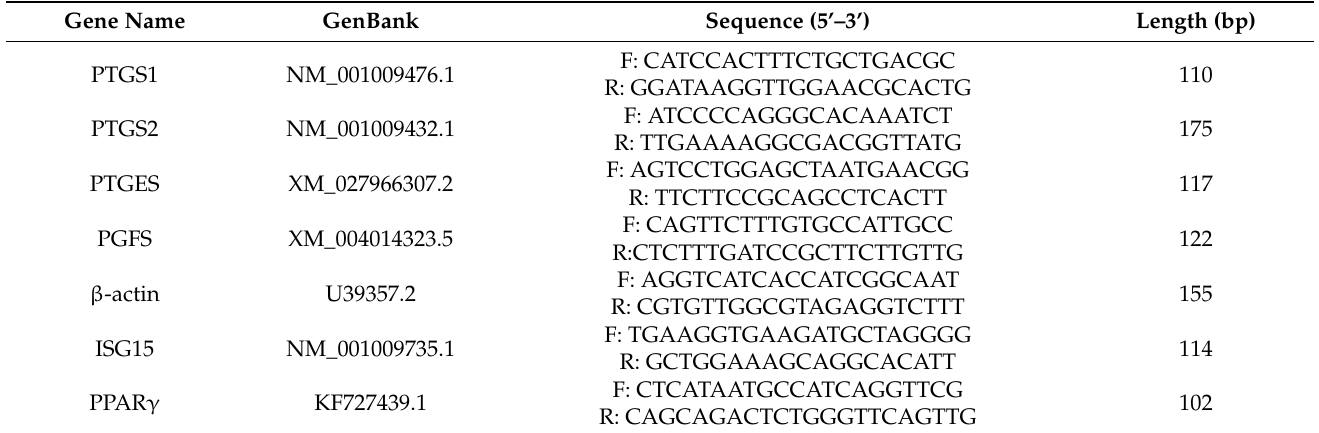
Table 1. Primers used for qPCR determination of relative mRNA